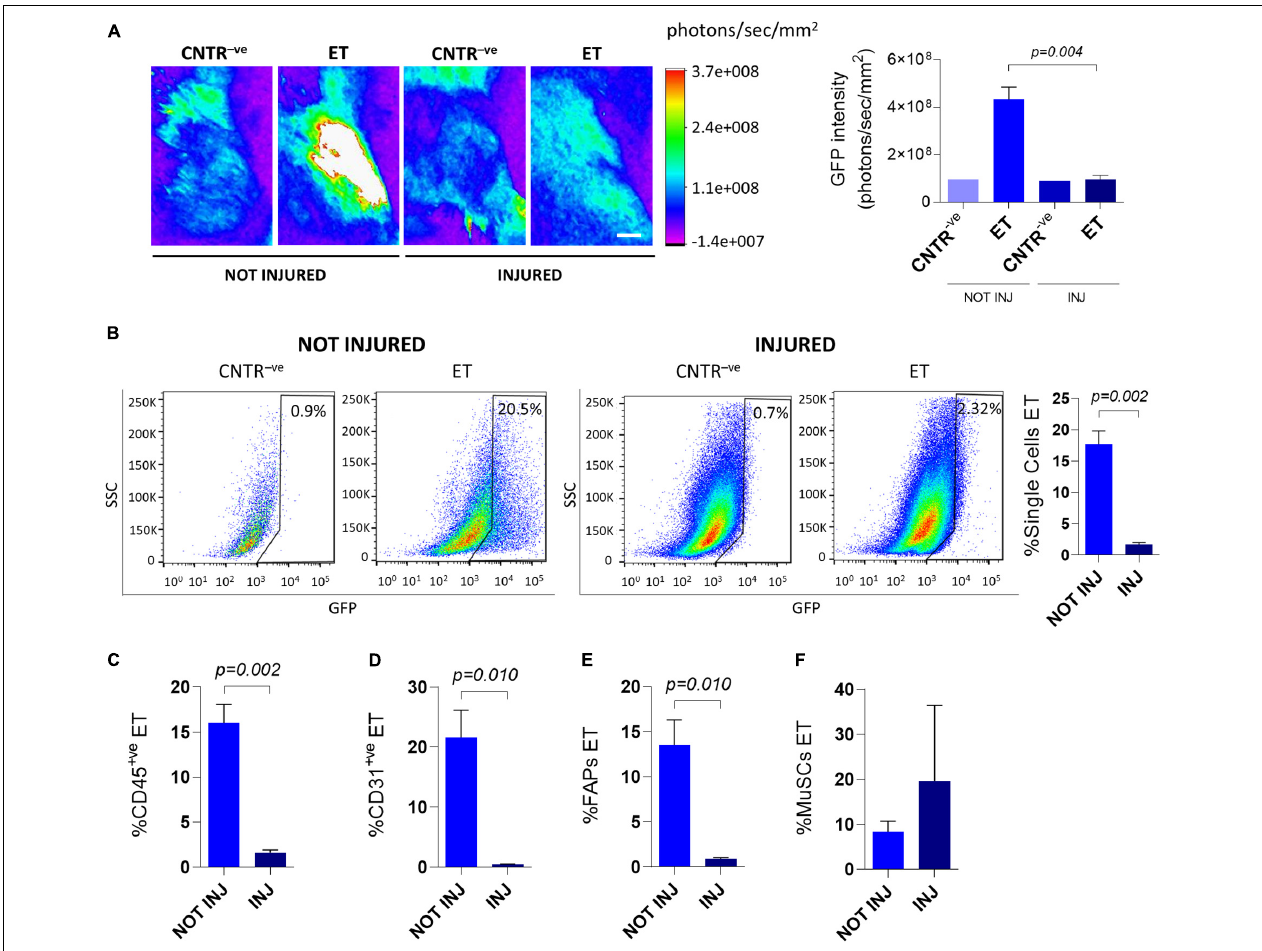
FIGURE 2 | In vivo electroporation of injured muscles . (A) Representative Bruker In Vivo Xtreme I images (left) and GFP intensity measurement (photons/sec/mm 2 ) (right) of TA muscles from ∼ 8 months-old C57BL/6J mice uninjured (NOT INJ) or injected with cardiotoxin (INJ). Mice were injected with PBS (CNTR – ve ) or GFP plasmid (ET) and electroporated 1.5 days after cardiotoxin injection. Scale bar: 2.5 mm. White color in the figure indicates photons/sec/mm 2 > 3.7e+008, Muscles were analyzed 5 days after electroporation. N = 3 (ET), N = 1 (CNTR – ve ). (B) Representative FACS plot (left) and quantification (right) of electroporated (ET, GFP + ve ) single cells from TA of ∼ 8 months-old C57BL/6J mice uninjured (NOT INJ) or injected with cardiotoxin (INJ). Mice were injected with PBS (CNTR – ve ) or GFP plasmid (ET) and electroporated 1.5 days after the cardiotoxin injection. The analysis was performed 6 days after electroporation. N = 3 (ET). (C–F) Quantification of electroporated (ET) CD45 + ve cells (C) , CD31 + ve cells (D) , FAPs (E) and MuSCs (F) from TA of the same mice as in panel (B) . All CNTR – ve gates were set on control samples (i.e., sample injected with PBS and electroporated). The percentage of ET cells in each CNTR – ve gate was < 1% for all the analyzed cell